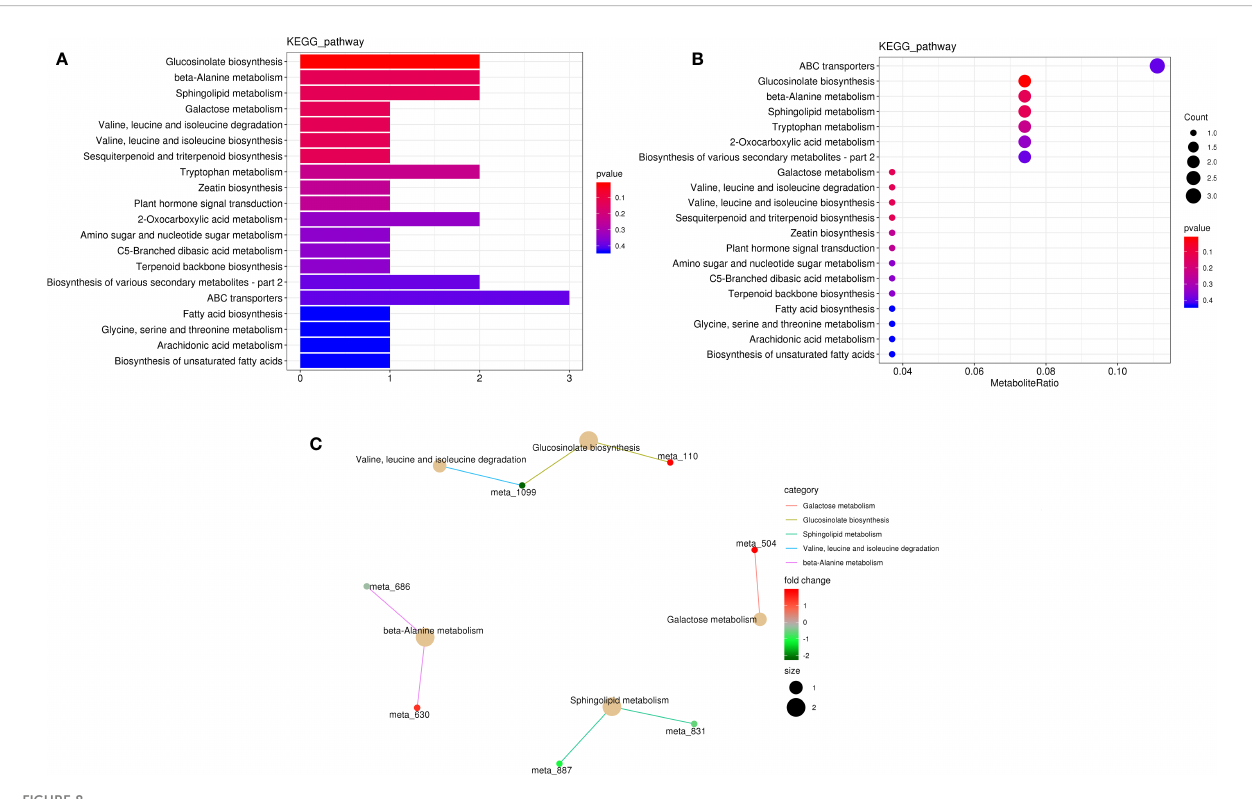
FIGURE 8 Metabolite pathway analysis in K 0 vs. K ck . (A) Classi fi cation diagram of different metabolite pathways in each group. The X-axis indicates the number of DAMs annotated to a pathway, and the Y-axis indicates the name of the pathway. (B) Enrichment map of DAMs in KEGG pathways. The X-axis represents the ratio of the DAMs in a pathway to all DAMs with pathway annotation. (C) KEGG enrichment network diagram of DAMs. The light-yellow node indicates the pathway, and the small node connected to it indicates the speci fi c metabolite annotated to the pathway. Color depth represents Log2(FC). The fi gure shows up to fi ve